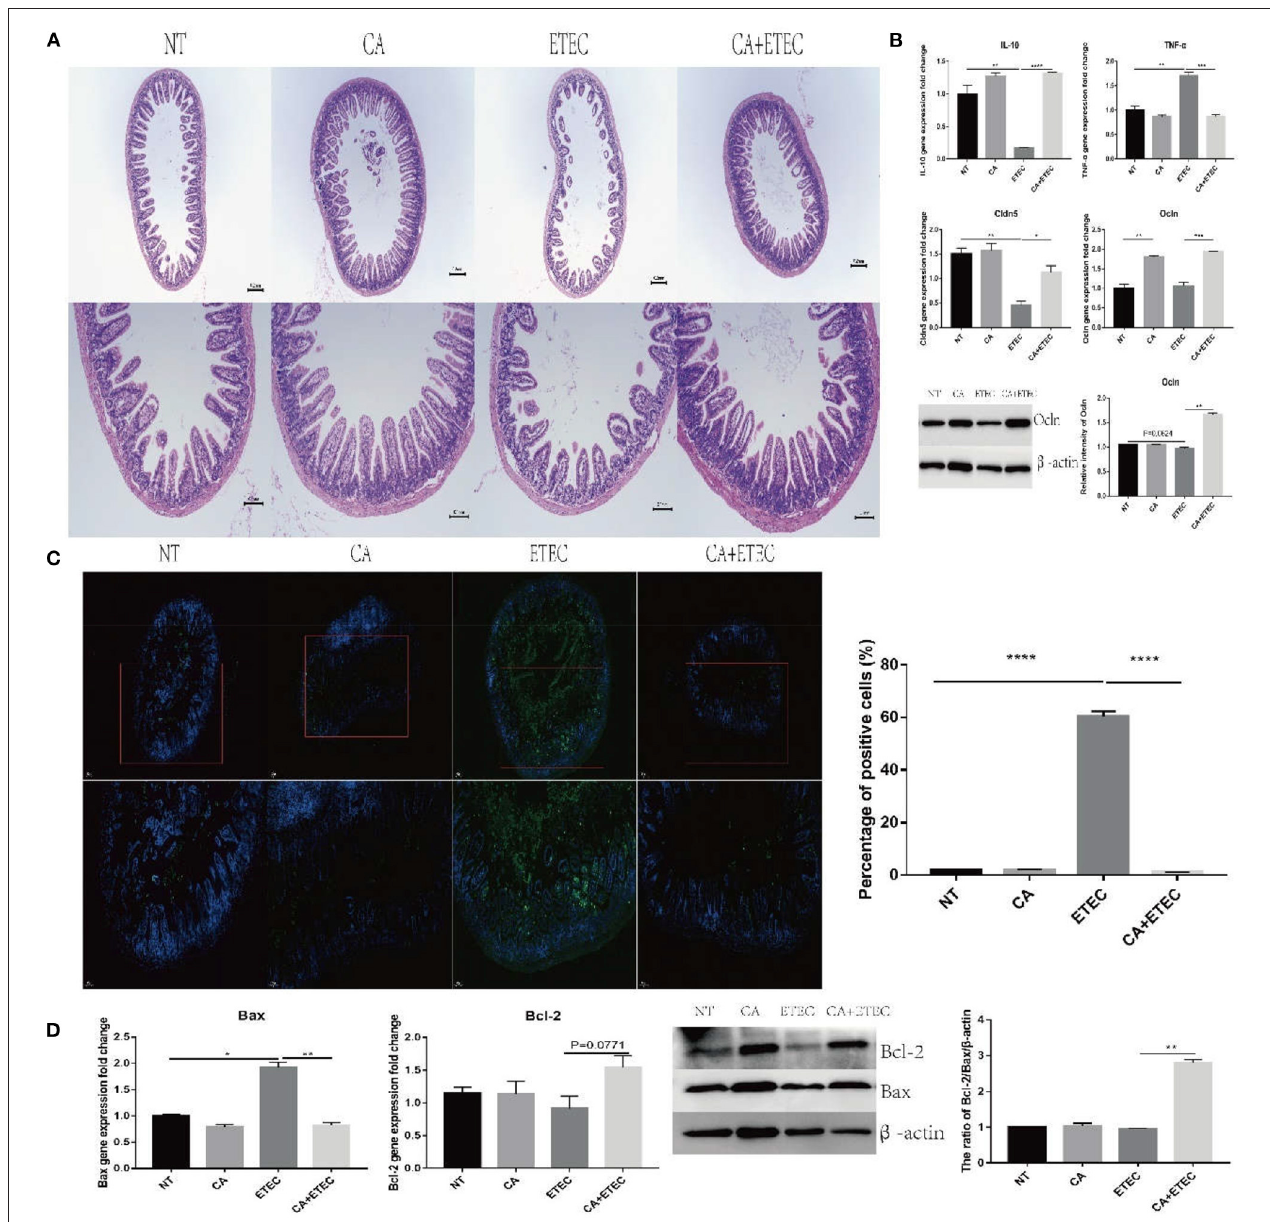
FIGURE 6 | Citric acid (CA) inhibited the inflammation and apoptosis of ileum in mice infected by ETEC. (A) HE staining analysis of ileum of mice. (B) Expression of IL-10, TNF- α , Cldn5, and Ocln was detected by RT-PCR. (C) TUNEL staining analysis of ileum of mice. (D) The anti-apoptotic effects of CA on mice ileum. Representative immunoblot of Bax and Bcl-2 expression in mouse ileum ( n = 3, means ± SEM, Student’s t -test, * P < 0.05, ** P < 0.01, *** P < 0.001, **** P <